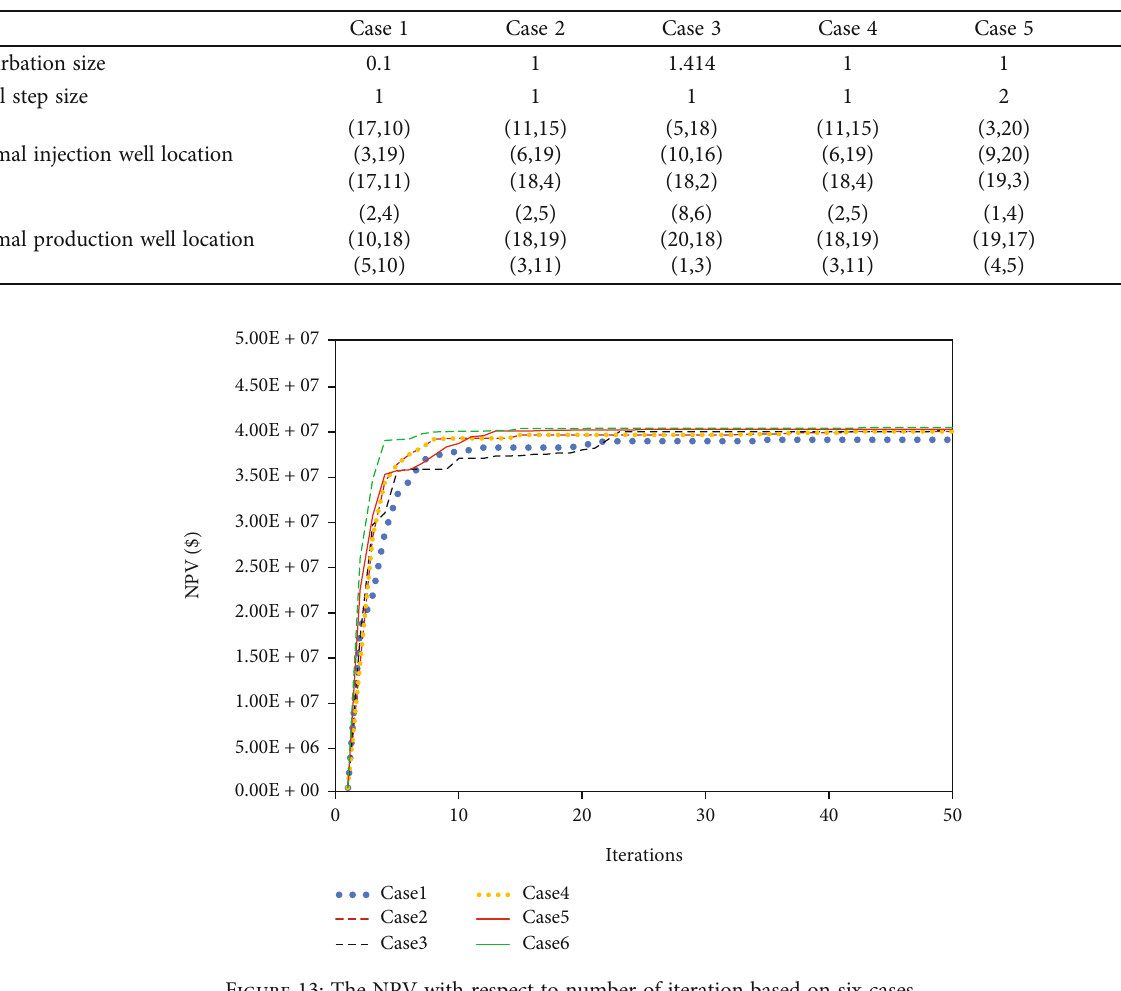
Table 3: Result of optimal well locations.